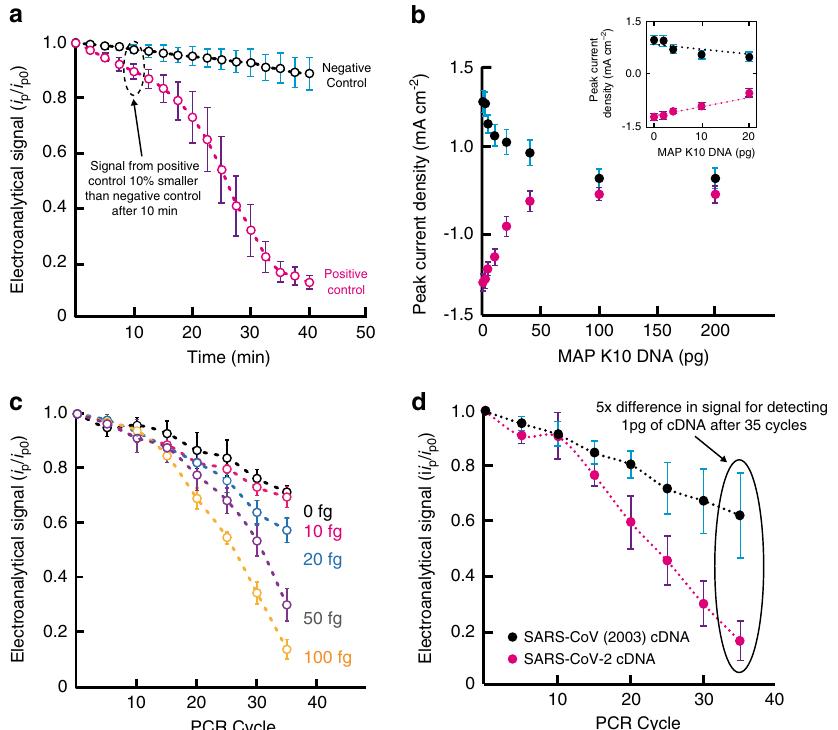
Fig. 5 Real-time quantitative NA ampli fi cation. a qRPA measurements performed using TriSilix showing a clear difference between the positive and negative control sample signals within 10 min ( N = 5). b Titration curve for direct electrochemical detection of genomic DNA from MAP K10 DNA without ampli fi cation over 0 – 200 pg ( N = 3). c qPCR measurements performed using TriSilix of genomic DNA from MAP K10 against CTMX-ESBL as negative control (0 fg). d TriSilix qPCR measurement for a synthetic fragment of cDNA from SARS-CoV-2 against a synthetic fragment of cDNA from SARS-CoV (2003) as negative sample. Clear separation between signals after 20 cycles (~40 mins), indicating rapid, on-site detection is possible using TriSilix ( N = 3). In all experiments shown in this fi gure, each repeat is performed with a new TriSilix chip and error bars correspond to standard deviations between